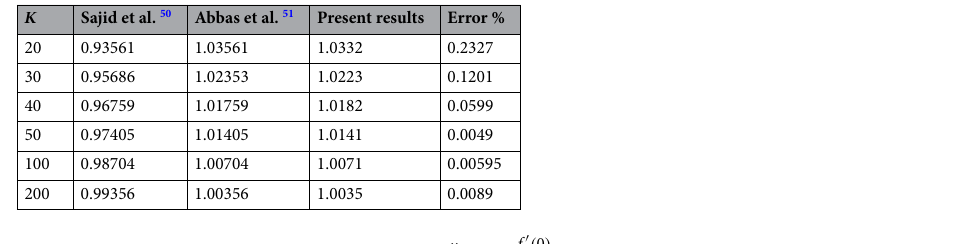
′ ( 0 ) K with the existing literature for validation.